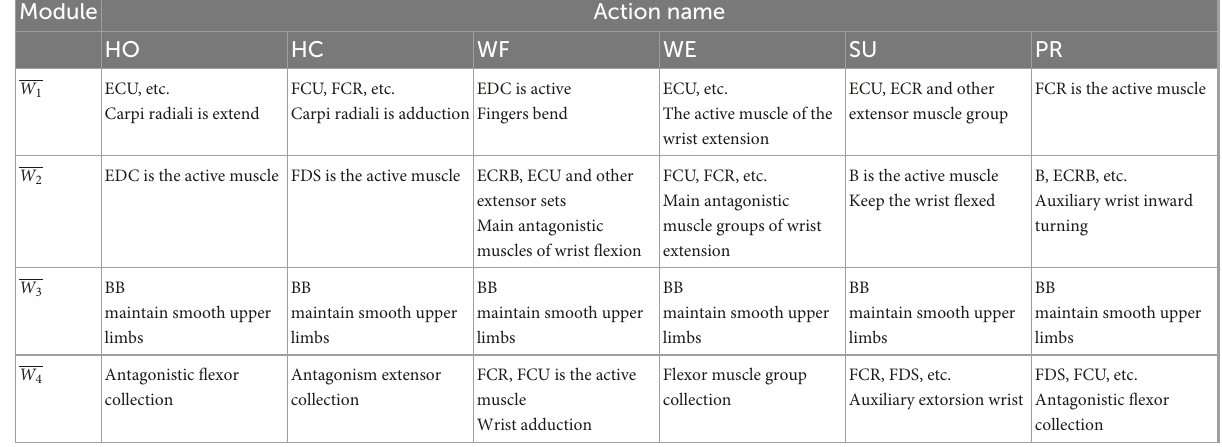
TABLE 2 The analysis of major activated muscle groups in different modules under different actions.